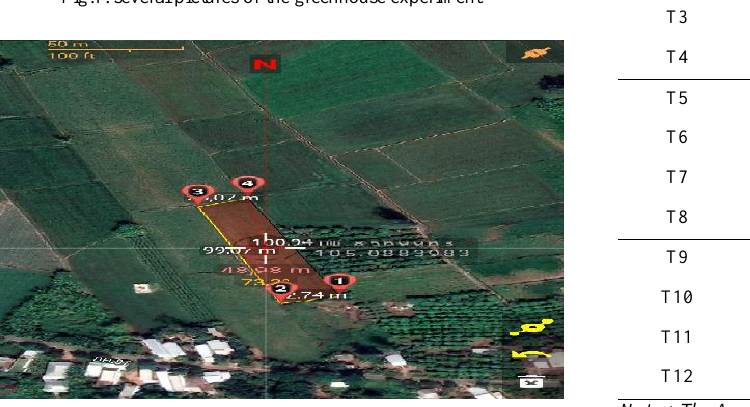
Fig.1. several pictures of the greenhouse experiment